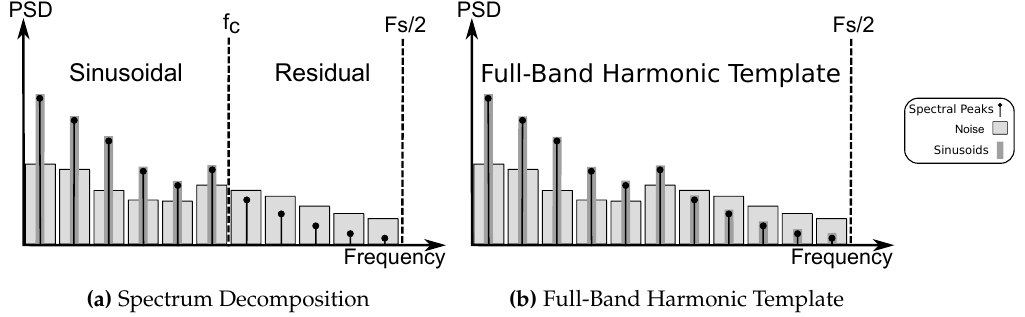
Figure 1. Illustration of the spectral decomposition and full-band modeling